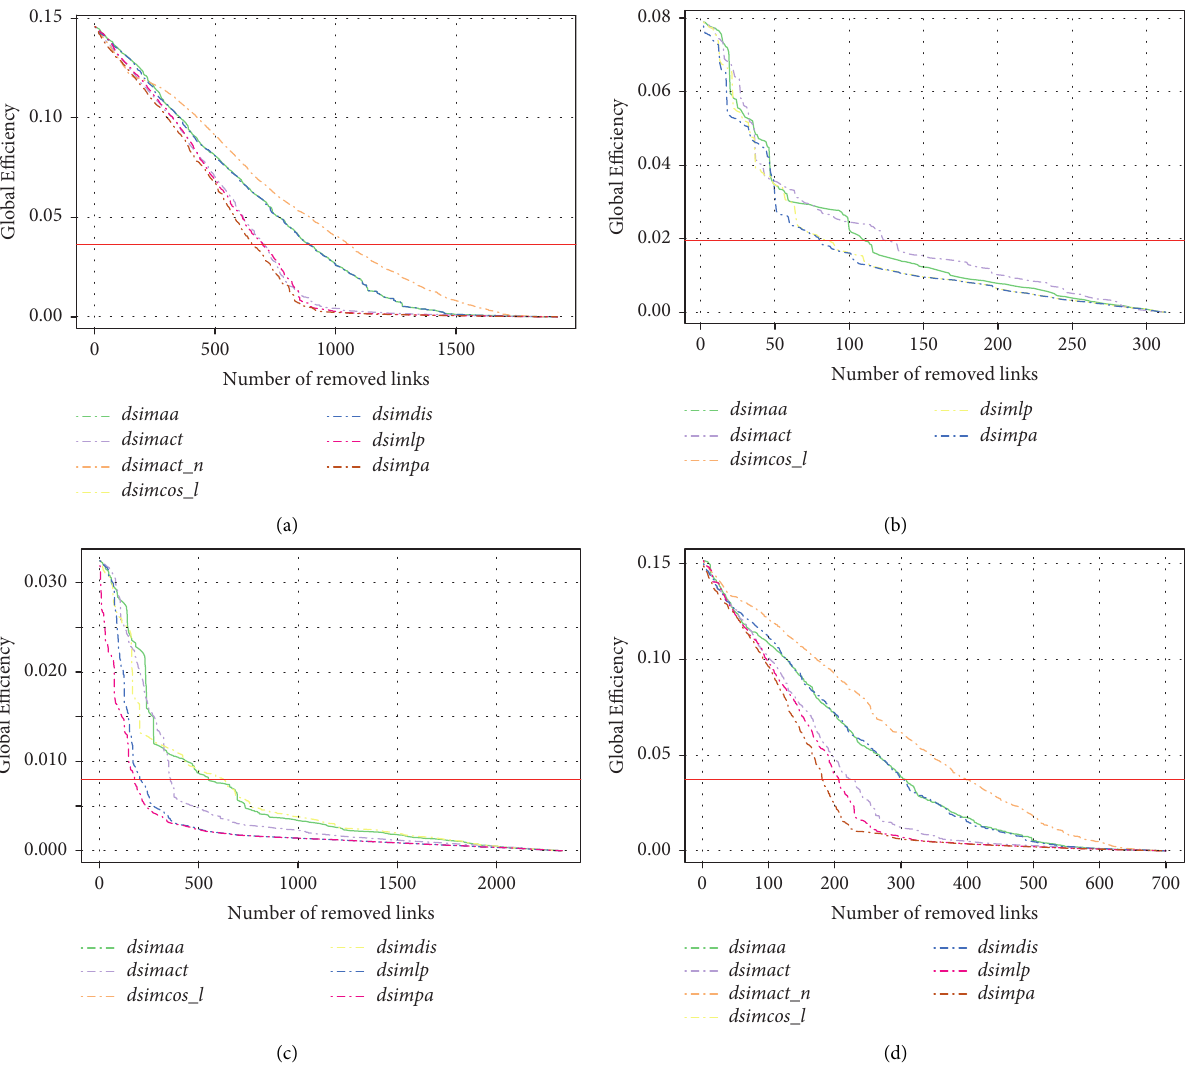
Figure 5: Variation in global efficiency when links with certain similarity characteristics are removed in AVL, CFL, RGTR, and TICE (a), Island Transit (b), Lanta (c), and Linja-Karjala Oy (d)